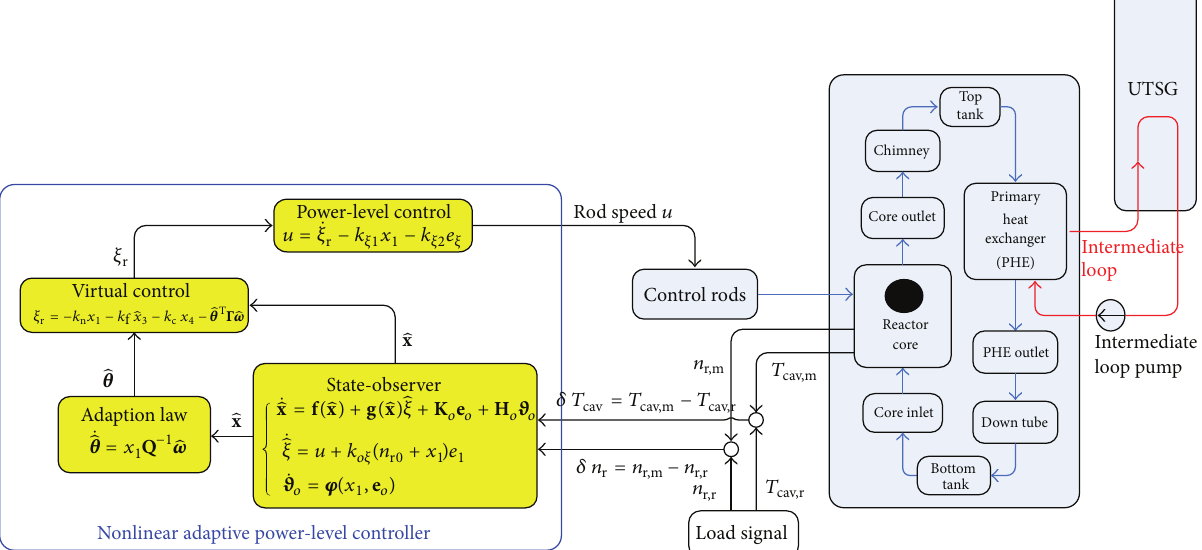
Figure 2: Block diagram representation of the closed-loop structure.